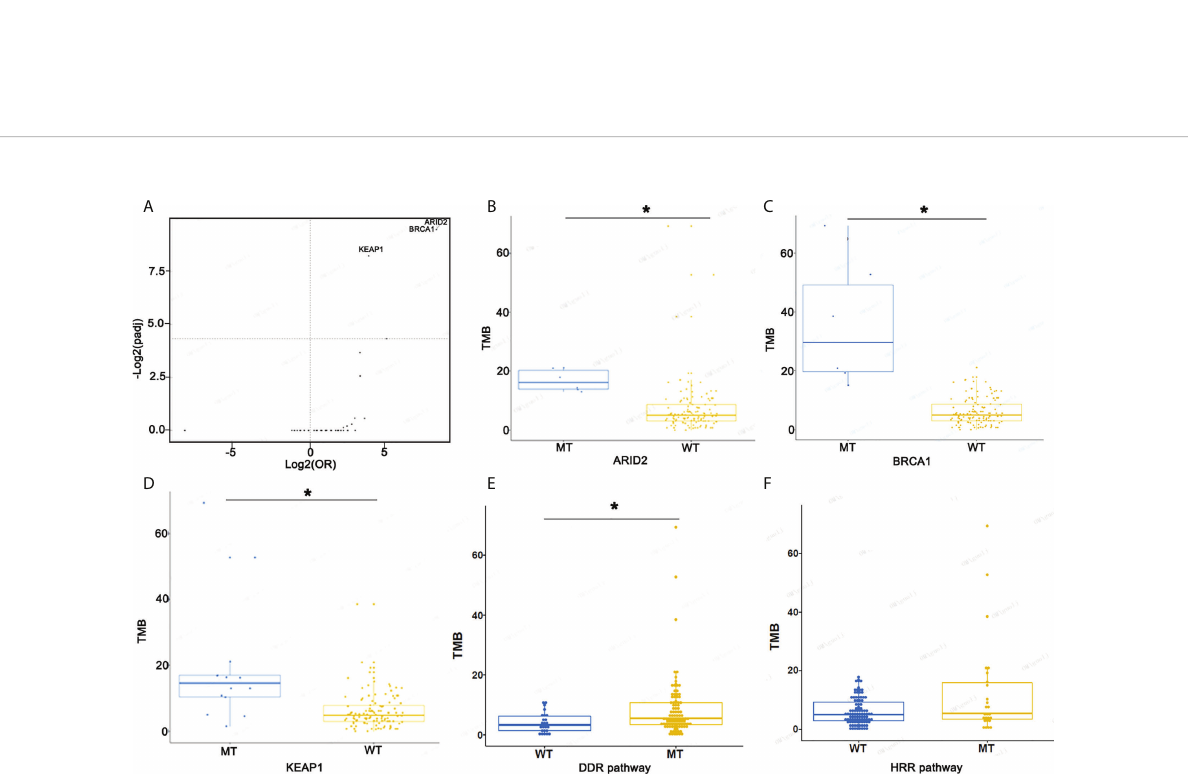
FIGURE 5 Screen mutational genes and pathways related to TMB. (A) The association of mutational genes and TMB. (B) TMB in patients with ARID2 -MT and ARID2 -WT. (C) TMB in patients with BRCA1 -MT and BRCA1 -WT. (D) TMB in patients with KEAP1 -MT and KEAP1 -WT. (E, F) TMB in patients with WT or MT in the DDR and HRR pathways *p <